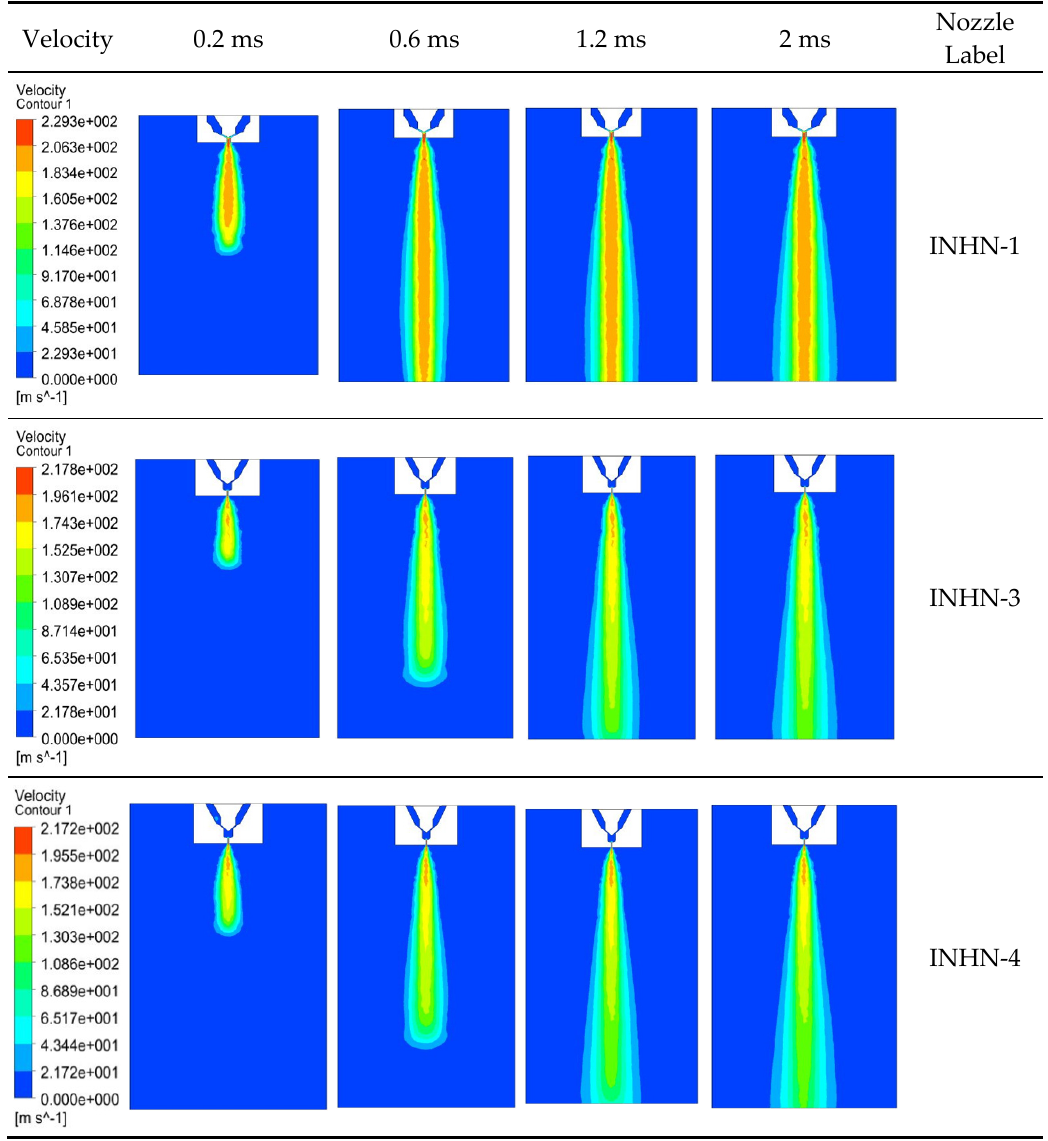
Figure 10. Spray domain model contour velocity for INHN-1, INHN-3 and INHN-4.